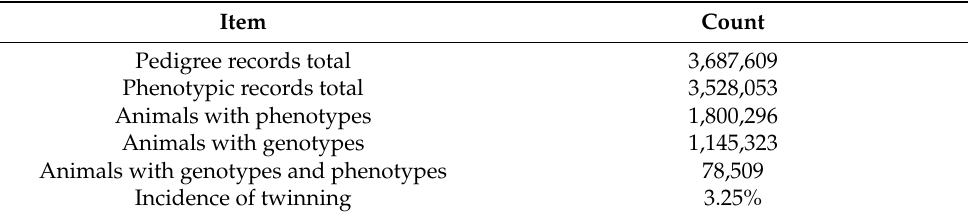
Table 2. Characteristics of the data in the genomic evaluation for twinning in Holsteins (August 2020).